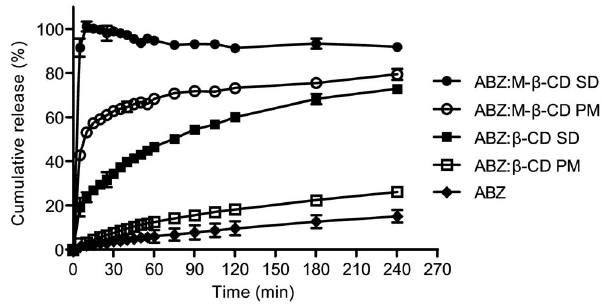
Figure 5. Dissolution profiles. Release profiles of ABZ (raw material), ABZ loaded in physical mixtures ( b -CD and RM- b -CD), ABZ loaded in the inclusion complexes (spray drying) ( b -CD and RM- b -CD). Test condi- tions: 0.1N HCl, 37 u C (n=3 6 SD).